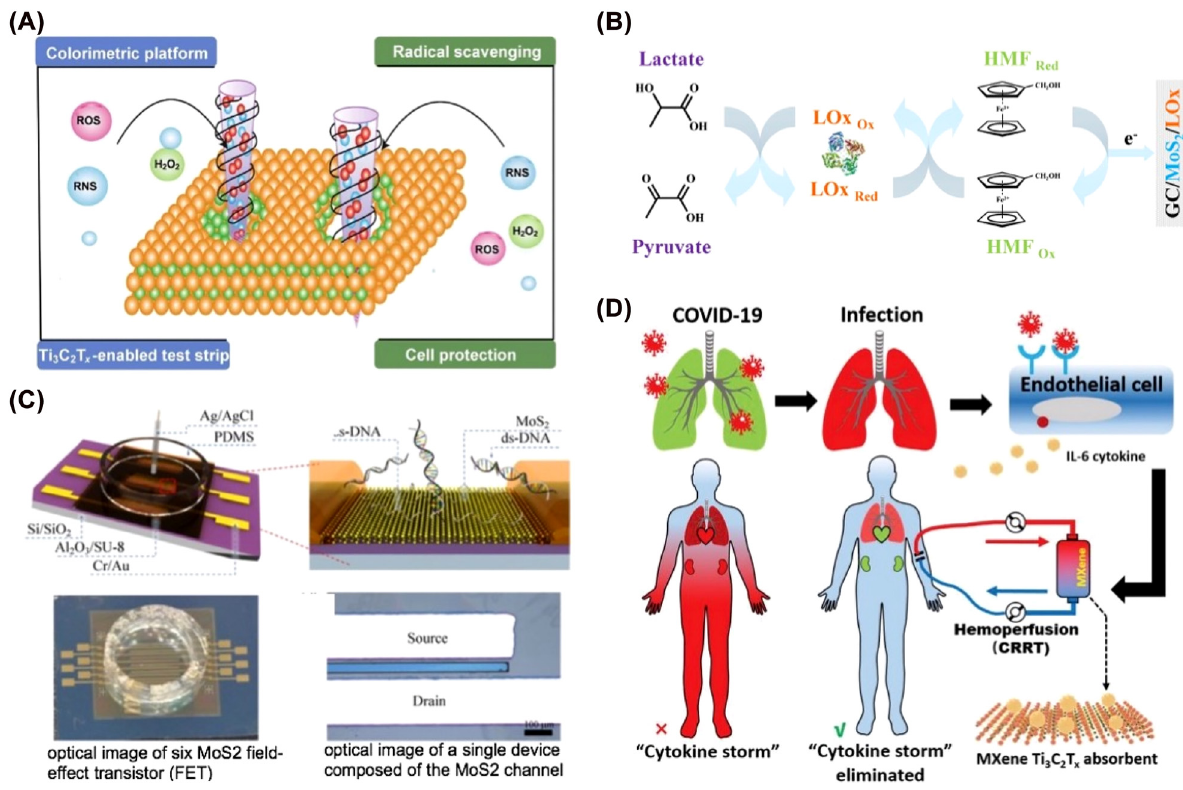
C nanosheet as a colorimetric strip for reactive oxygen 3 2 C T is an 3 2 x